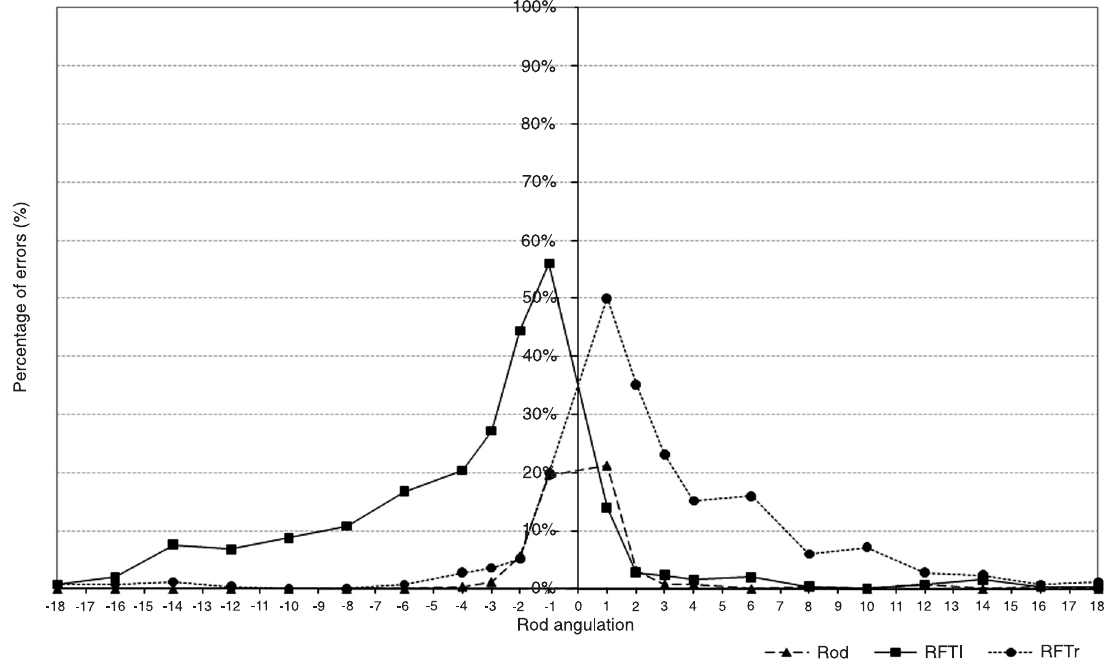
Figure 1. Percentage of errors per rod angle in SVV and RFT. N = 50. SVV = subjective visual vertical; RFTl = rod and frame test, frame tilted to the left; RFTr = rod and frame test, frame tilted to the